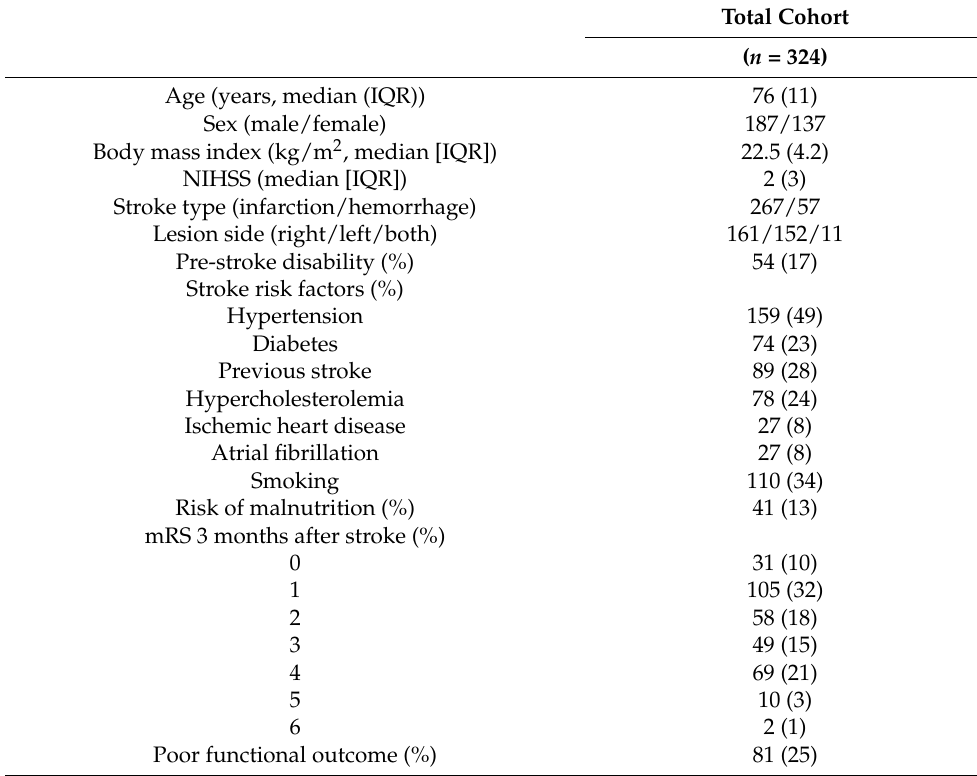
Table 1. Stroke patient